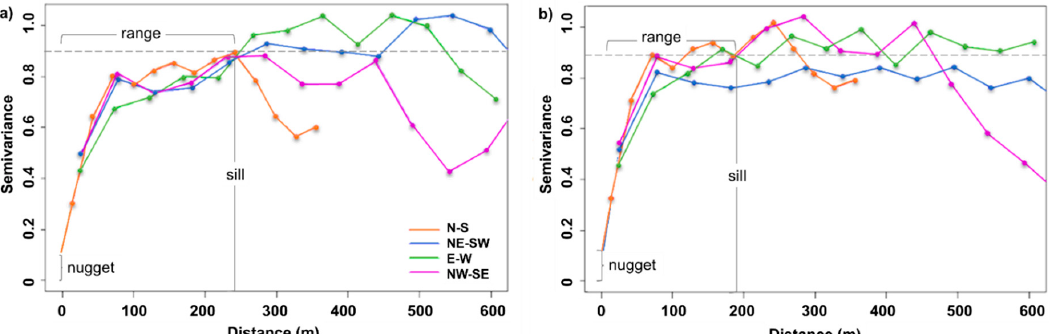
Figure 6. Directional empirical semi-variograms captured on September 18. ( a ) Semi-variograms for band 13 centered at 549 nm, reached the sill at a range of 240 m. ( b ) Semi-variograms for band 23 centered at 650 nm, reached the sill at a range of 180 m.